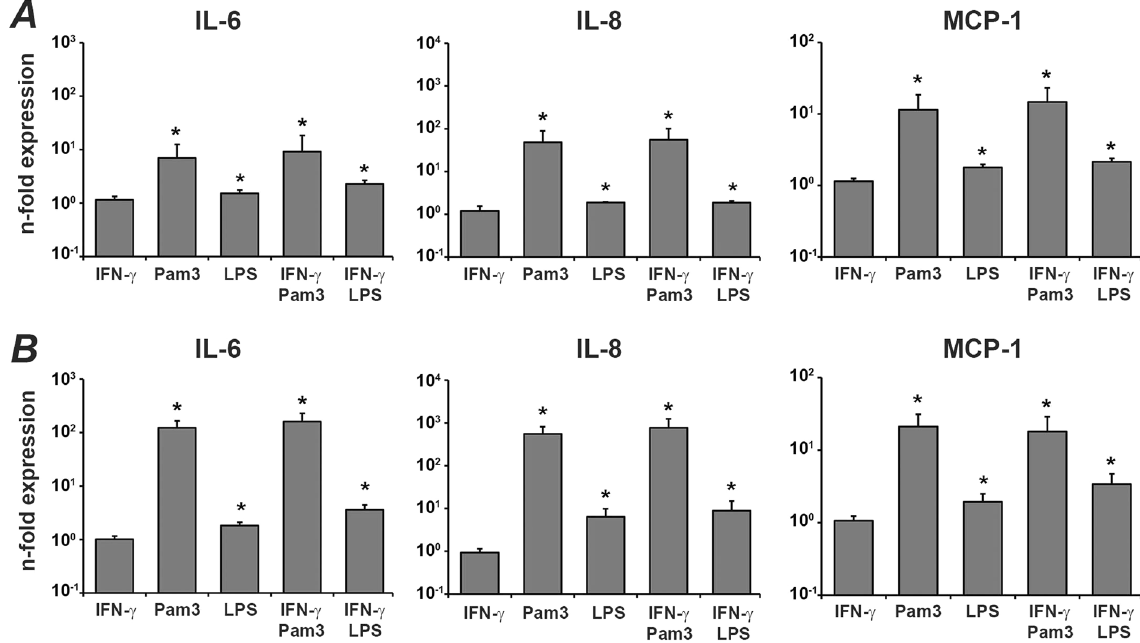
Figure 3. Effect of IFN- γ , Pam3CSK4, and E. coli LPS on the gene expression level of IL-6, IL-8, and MCP-1 in hPDLSC. Cells were stimulated with IFN- γ (10 ng/ml), TLR2 agonist Pam3CSK4 (1 µ g/ml), TLR4 agonist E. coli LPS (1 µ g/ml), or combinations of IFN- γ and TLR agonists for either 6 h ( A ) or 48 h ( B ) and resulting expression of IL-6, IL-8, and MCP-1 was measured by qPCR. Y-axis represents the n-fold expression levels of target gene in relation to unstimulated cells (n = 1). Data are presented as mean ± s.e.m. of 6 different donors. * significantly different compared to control.